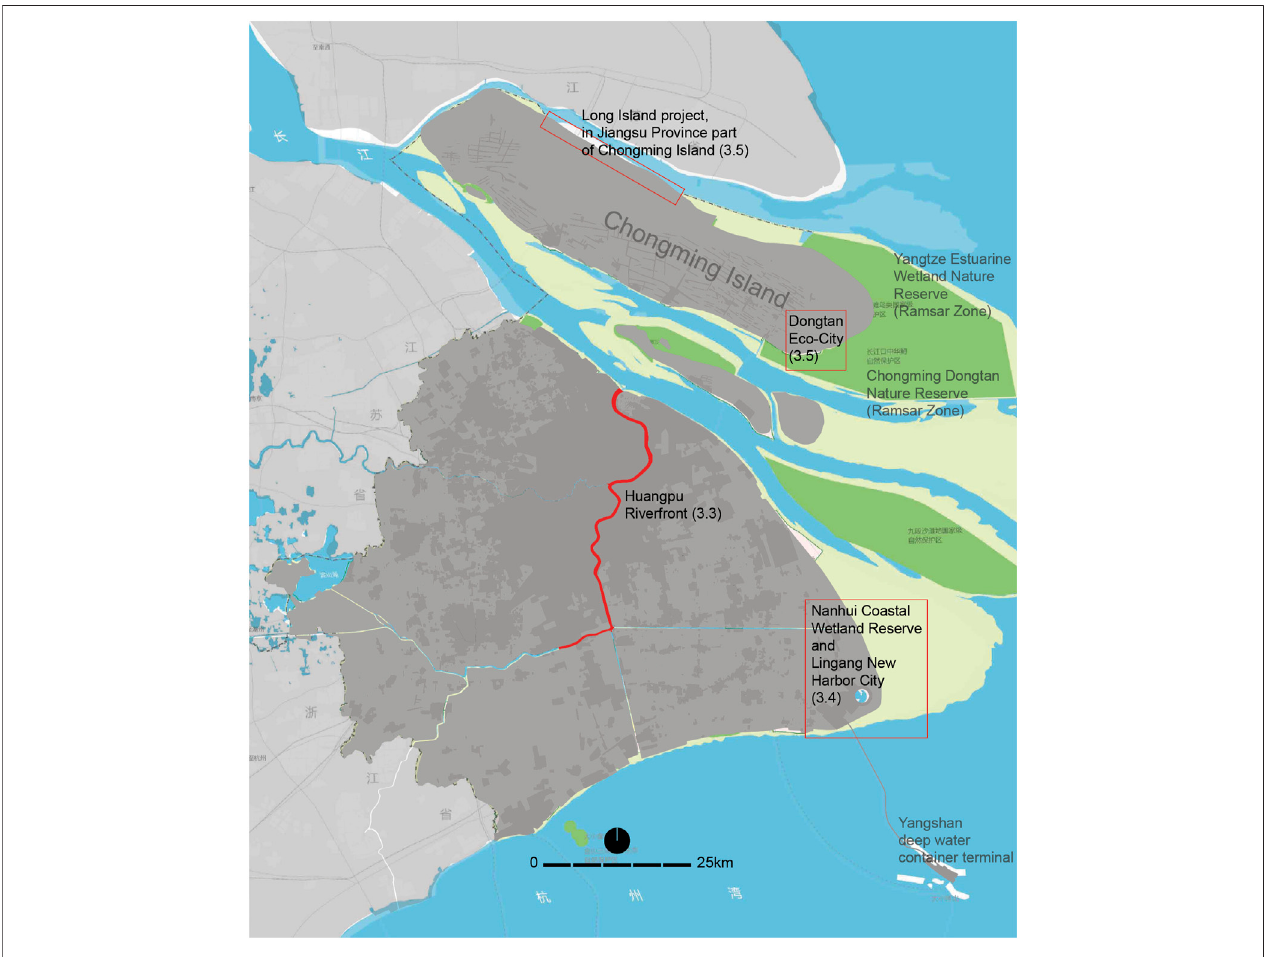
FIGURE 2 | Shanghai Direct Controlled Municipality with the locations mentioned in this article (image by author; green zones as underlay by SPLRA,